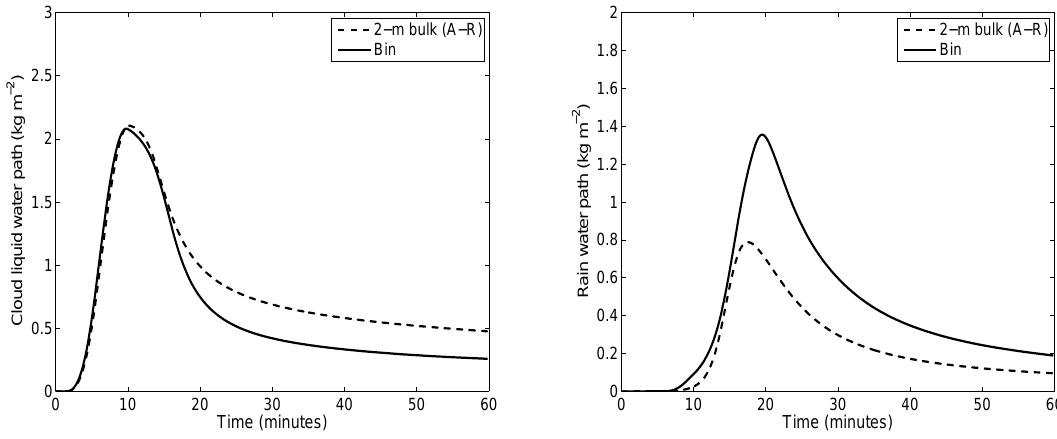
Fig. 5. Comparison of cloud liquid water path (left) and rain water path (right) in kgm − 2 from the 2-m A-R scheme (dashed) and bin scheme (solid), for those simulations shown in Fig. 4.